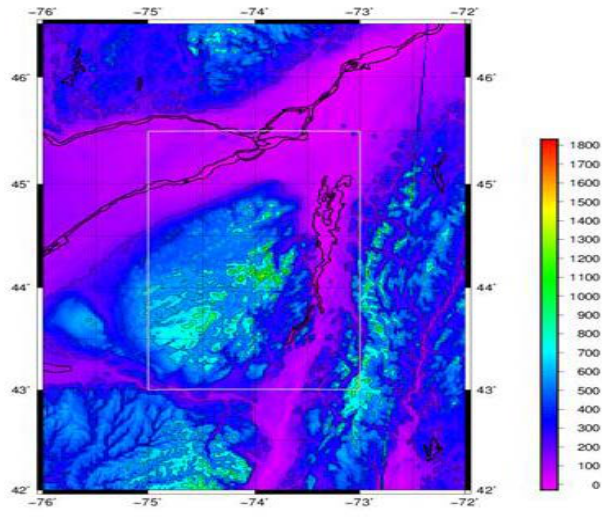
Figure 13: Topographical heights in the New Hampshire test area from SRTM 30” data in 10 meter contours. The height ranges from 0 to 1800